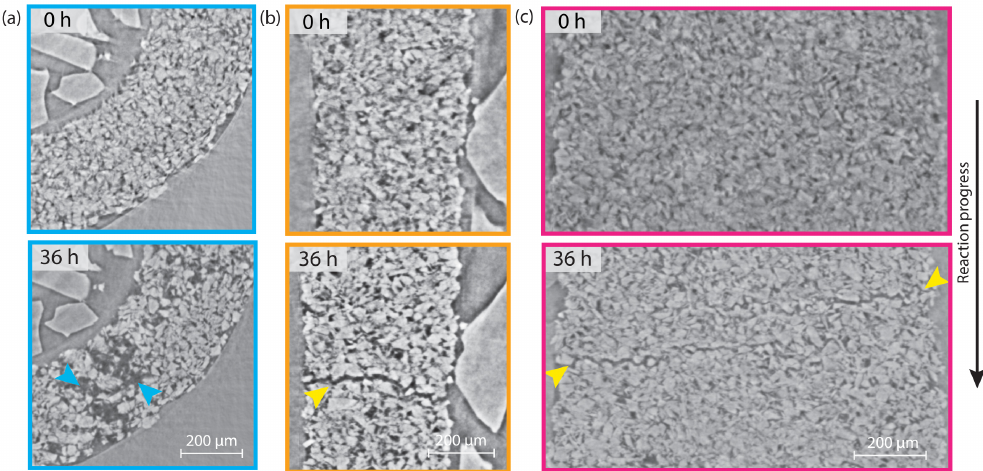
Figure 6. (a) Dissolution features in the cross-sectional images of the LGC sample. 3-D examination reveals that these dissolution features (blue arrowheads) are associated with planar fractures (yellow arrowheads) appeared in (b) the radial and (c) the tangential section images. The boarder color of each section corresponds to color code given in Fig.